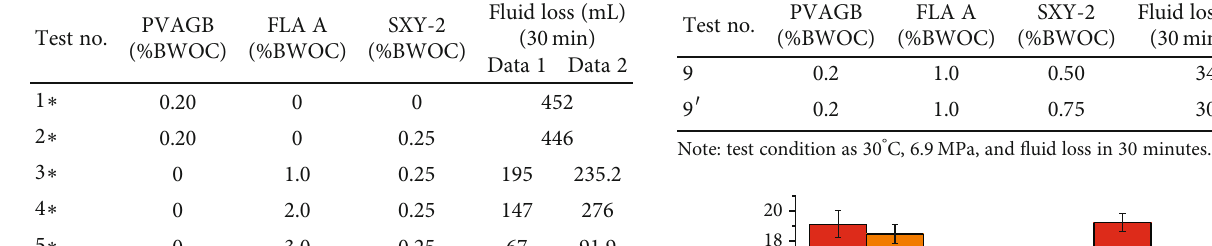
Table 5: Fluid loss test (comparison for SXY-2 added). Test no.